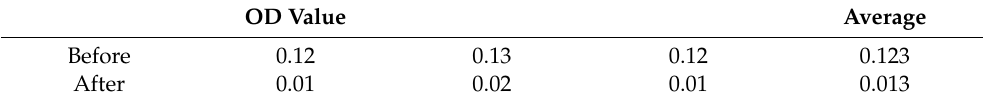
Table 1. The OD value of sPD-L1 in the in vitro circuit before and after plasma exchange. OD Value Before